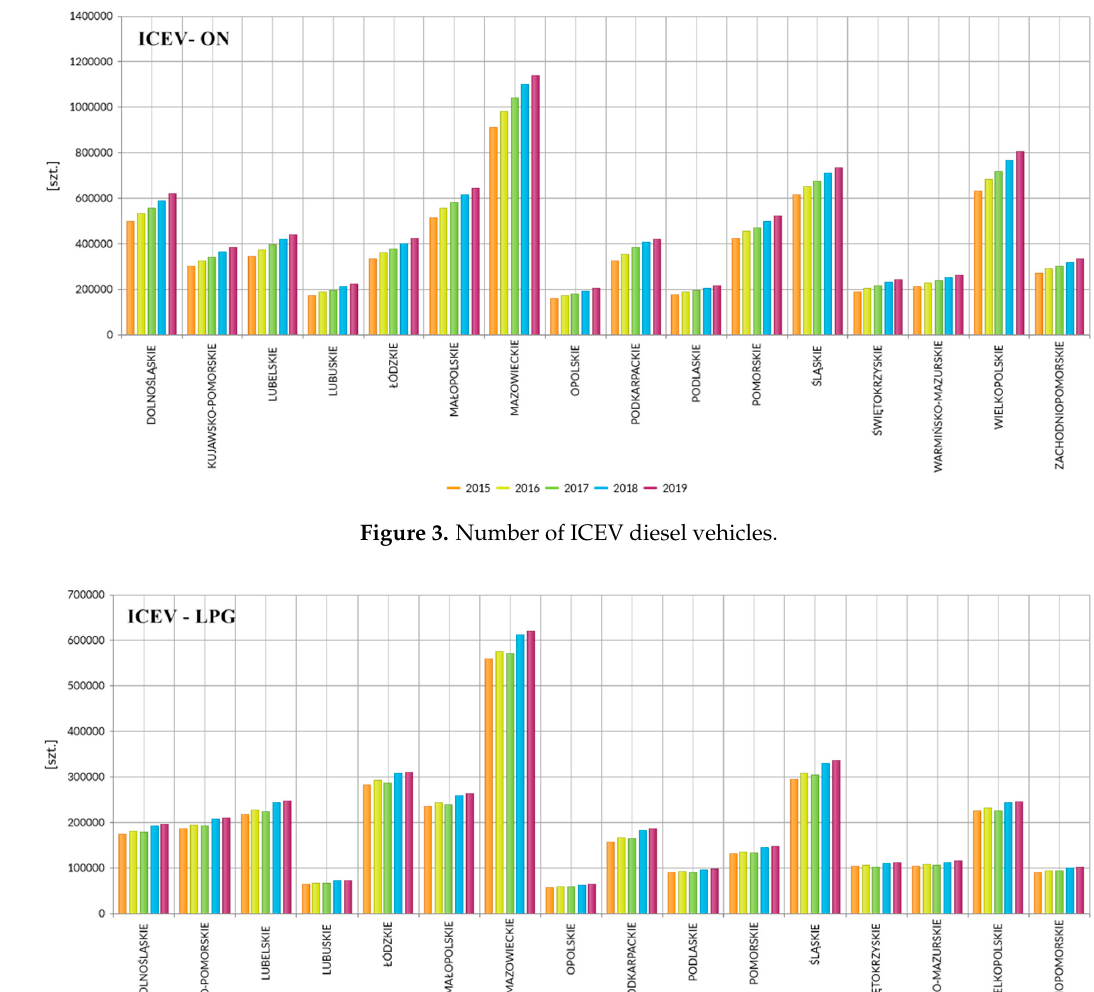
Figure 2. Number of ICEV petrol vehicles.